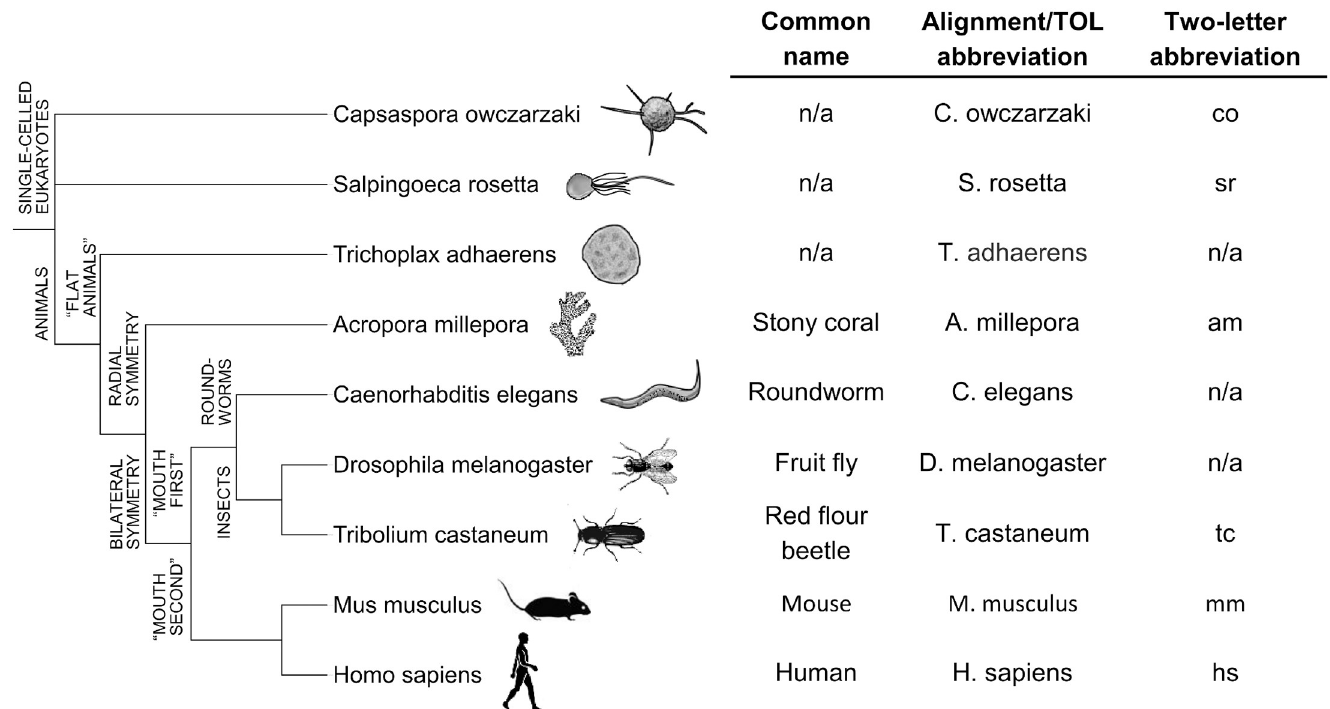
Fig 2. Evolutionary relationships and nomenclature of key eukaryotic species. Species which have previously undergone detailed molecular analysis of their HIF pathway components, including Caenorhabditis elegans [8], Drosophila melanogaster [34] and Trichoplax adhaerens [23], are shown in a cladogram with biochemically characterised species in the current work. An adjacent table shows species name abbreviations used in Fig 3 and sequence alignment figures, as well as two-letter abbreviations utilised for concise reference to various protein homologs (e.g. Tribolium castaneum FIH is abbreviated to “tcFIH”). A more comprehensive list of species name abbreviations can be found in S1 Table. n/a = not